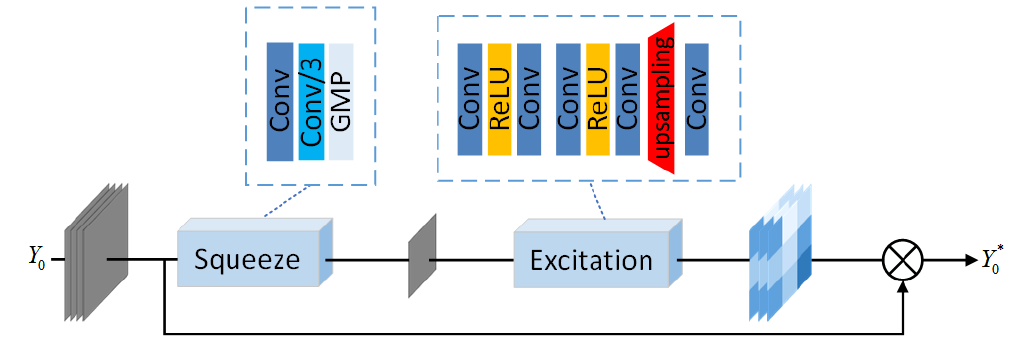
Figure 4. Architecture of the Large-Receptive-field-based Spatial Attention Module